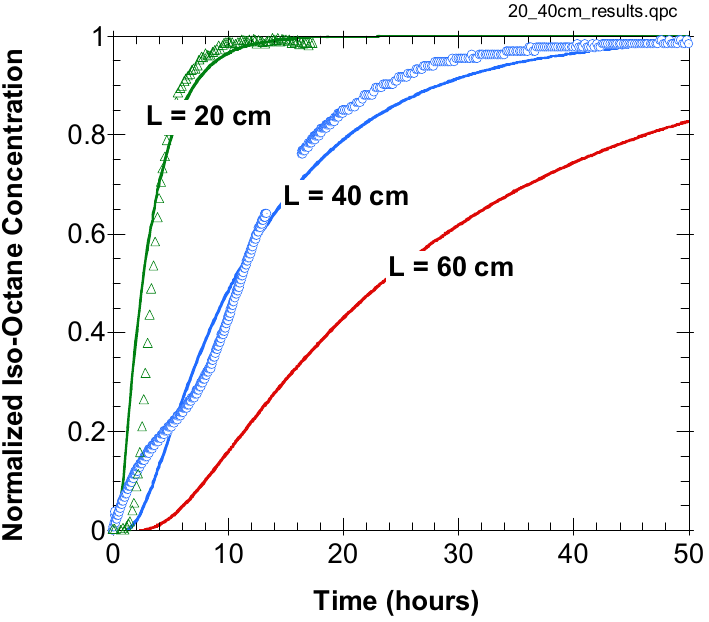
Figure 7. Plot of normalized concentration as a function of time for the 1-D column experiment. The data points are shown as symbols, and the results of the analytical solution are shown as solid lines for three assumed